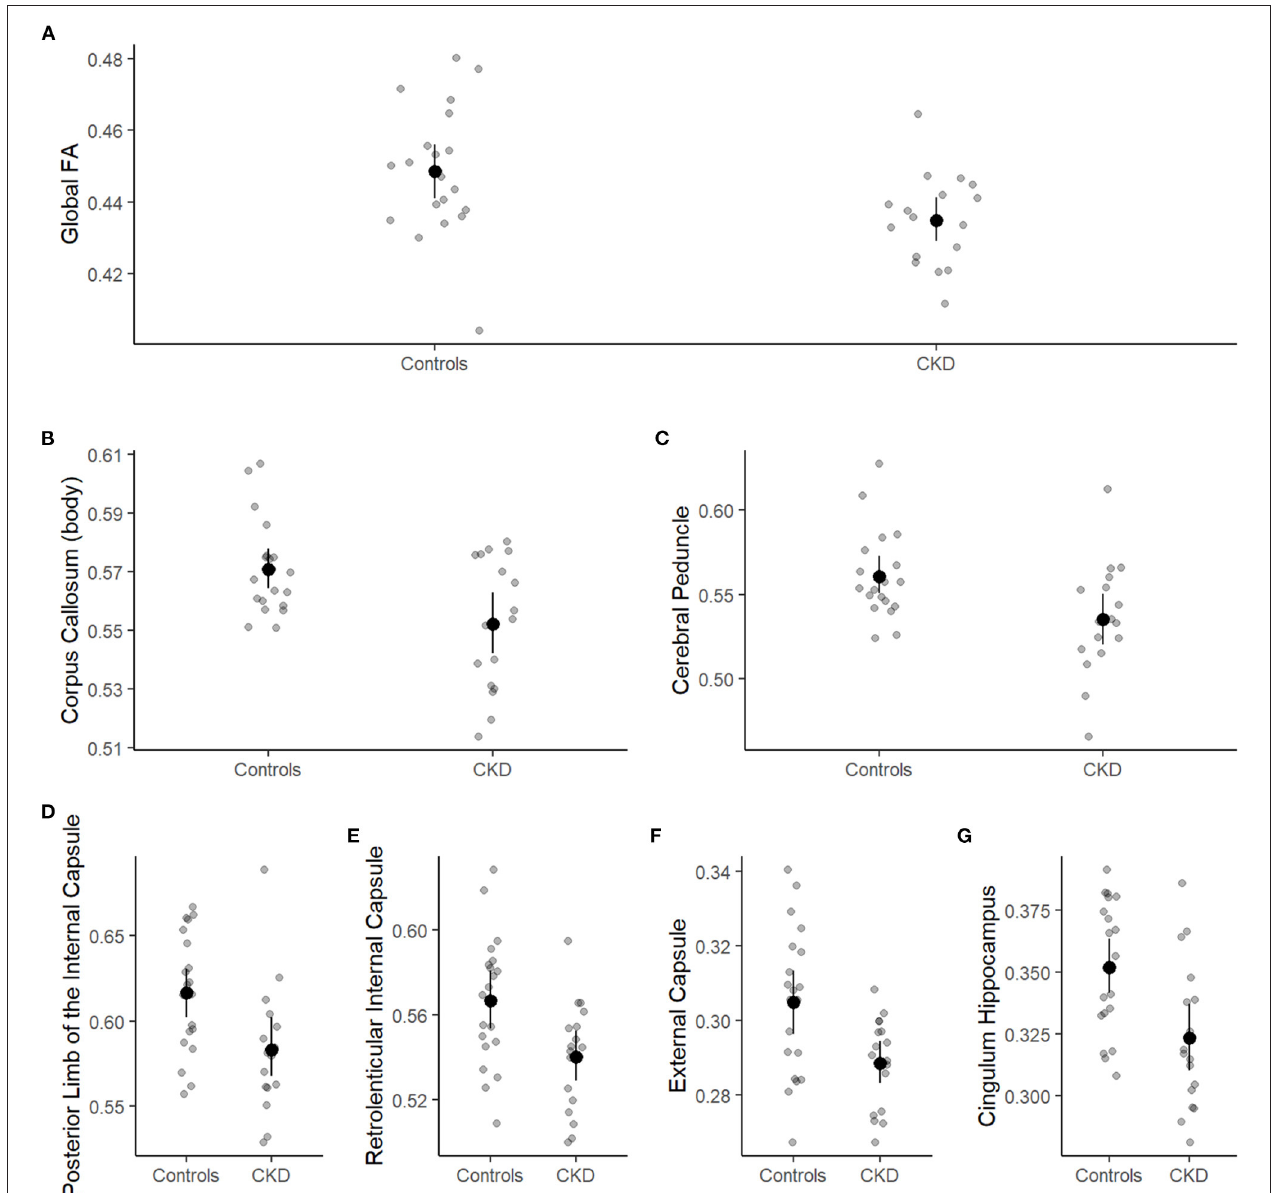
FIGURE 3 | Group differences in global and regional white matter fractional anisotropy. Patient group (case or control) is shown on the x-axis and white matter fractional anisotropy on the y-axis. Individual observations are represented by small, gray circles. Means and 95% confidence limits of the means are shown for each group. (A) Shows the global fractional anisotropy, and (B–G) show white matter fractional anisotropy for the corpus callosum, cerebral peduncle, posterior limb of the internal capsule, retrolenticular internal capsule, external capsule, and cingulum hippocampus,